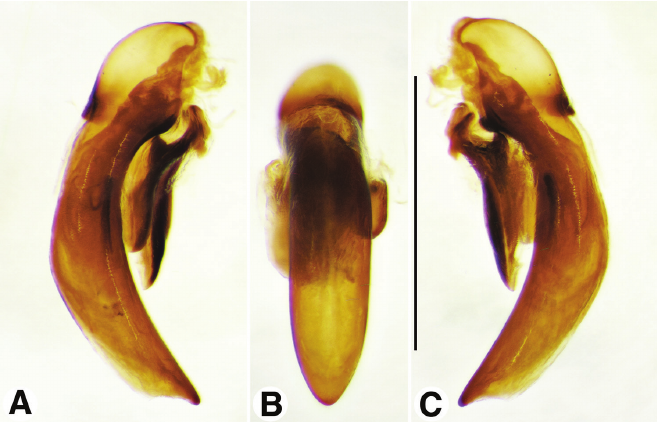
Figure 63. Digital images of male genitalia of Stenomorphus californicus manni Darlington. A right lateral aspect B dorsal aspect C left lateral aspect. Scale bar 1 mm.